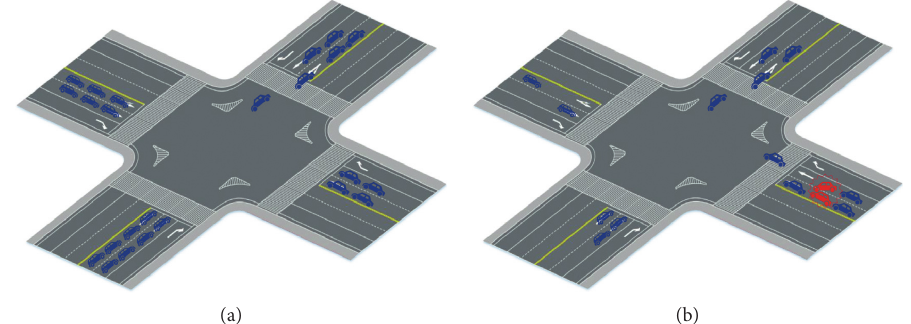
Figure 1: Oversaturation caused by different reasons. (a) Oversaturation of intersections due to large traffic demand and (b) oversaturation of intersections due to a traffic accident.